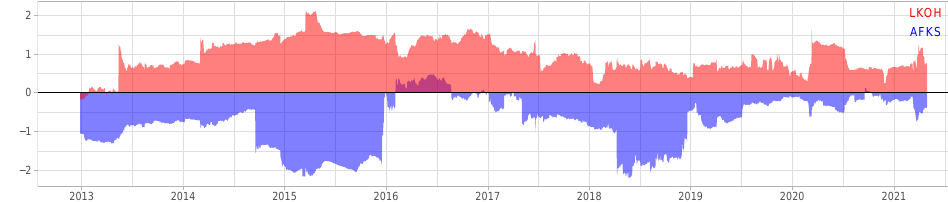
Figure 6. Net volatility spillover for LKOH and AFKS.